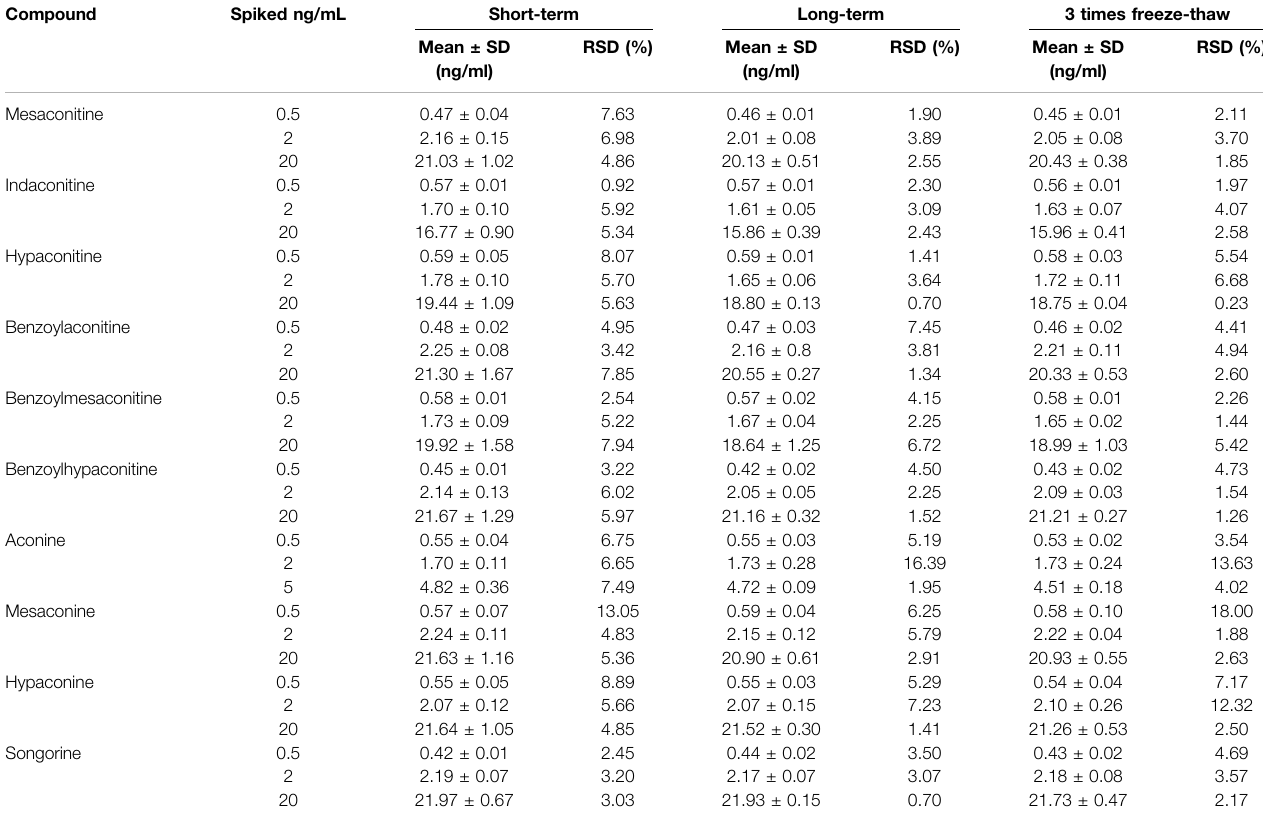
TABLE 4 | Stability of target compounds. Compound Spiked ng/mL